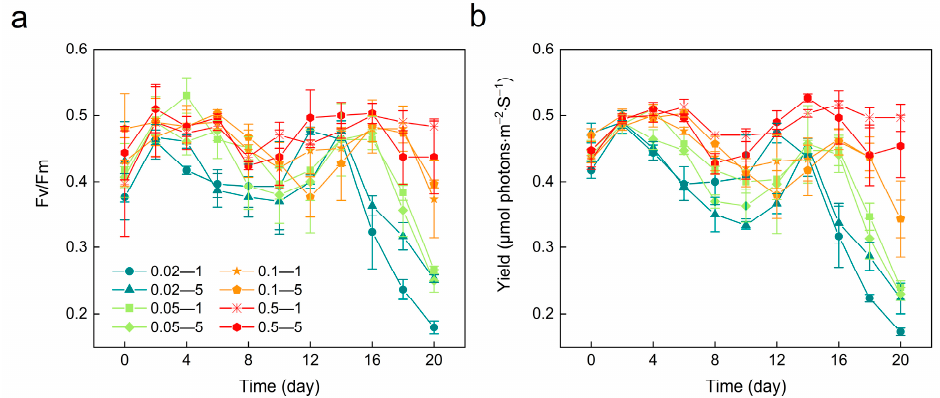
Figure 3. The changes in Fv/Fm ( a ) and the yield ( b ) of C. ovalisporum in different treatments.